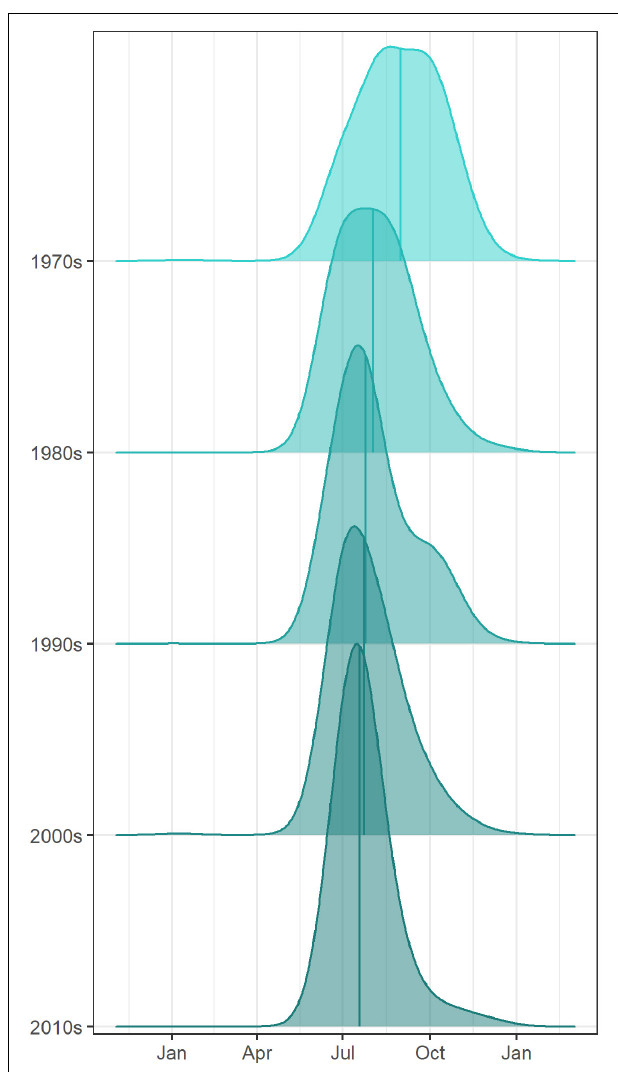
FIGURE 8 | Density plots of adult salmon moving upstream to spawn in the Burrishoole catchment. Densities are calculated from counts of fish per day, accumulated by decade between the 1970s and 2010s. Vertical lines indicate the median run time of each group of